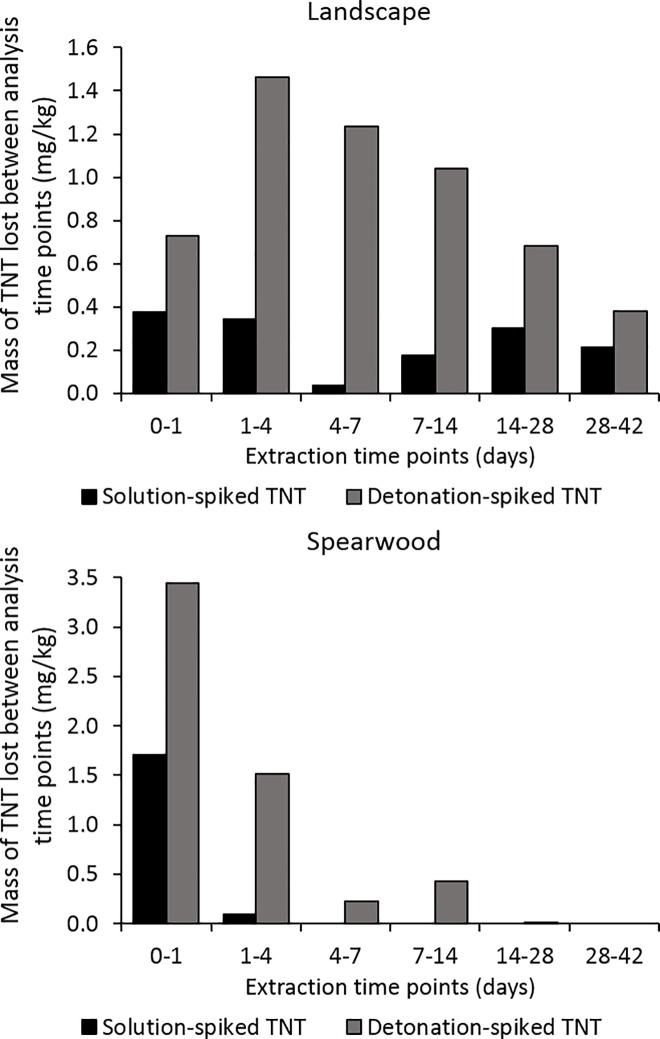
Average (n = 2) TNT loss between the analysis time points used for this work, from spiked pre-blast and post-blast samples.